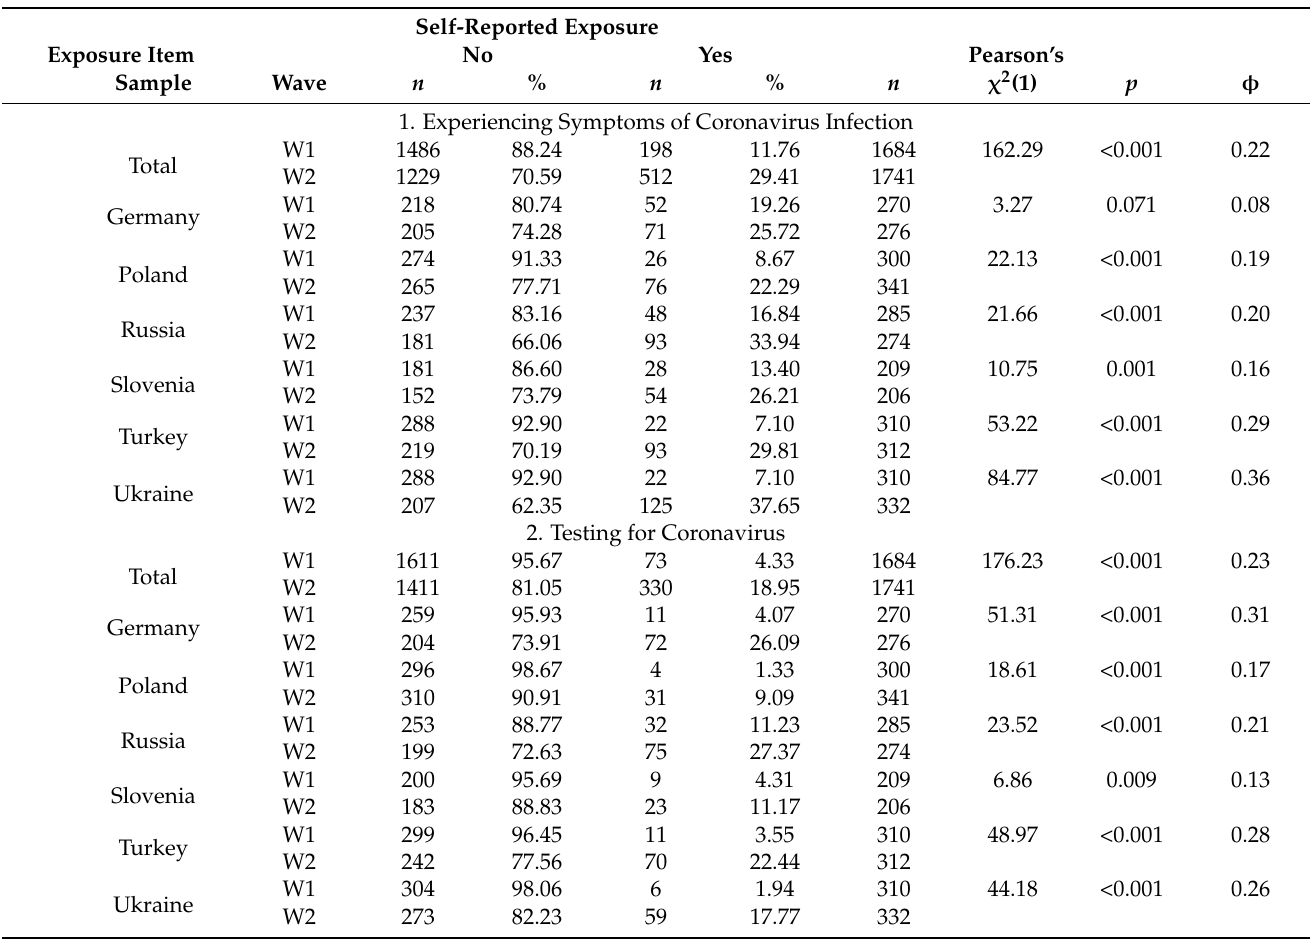
Table 2. Comparison of proportions of university students who experienced exposure to the coronavirus pandemic during